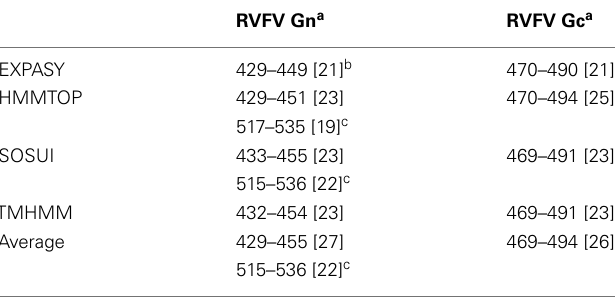
Table 1 | Prediction of location of transmembrane